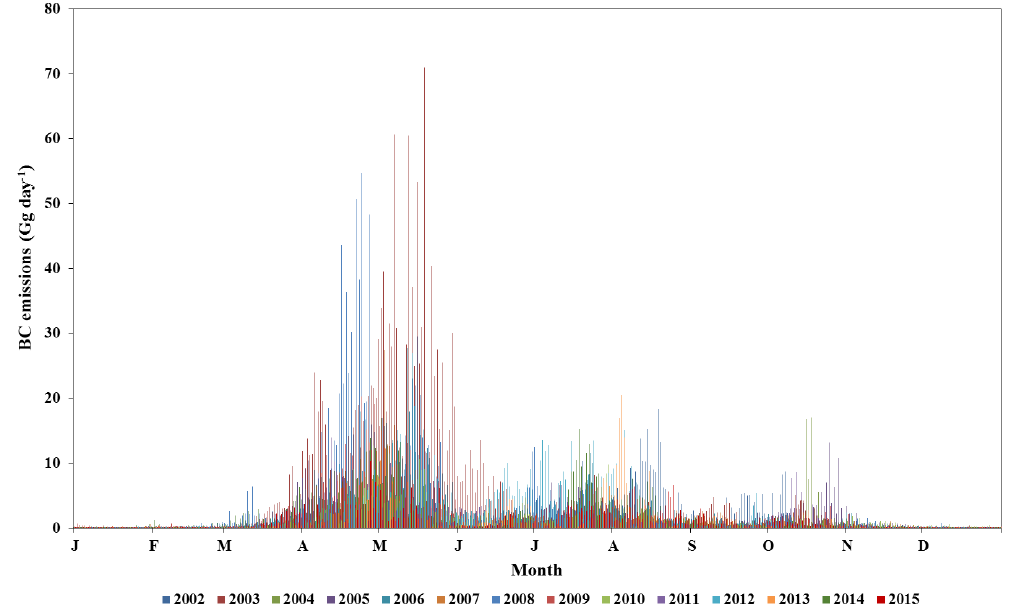
Figure 7. Daily BC emissions in northern Eurasia from 2002 to 2015.